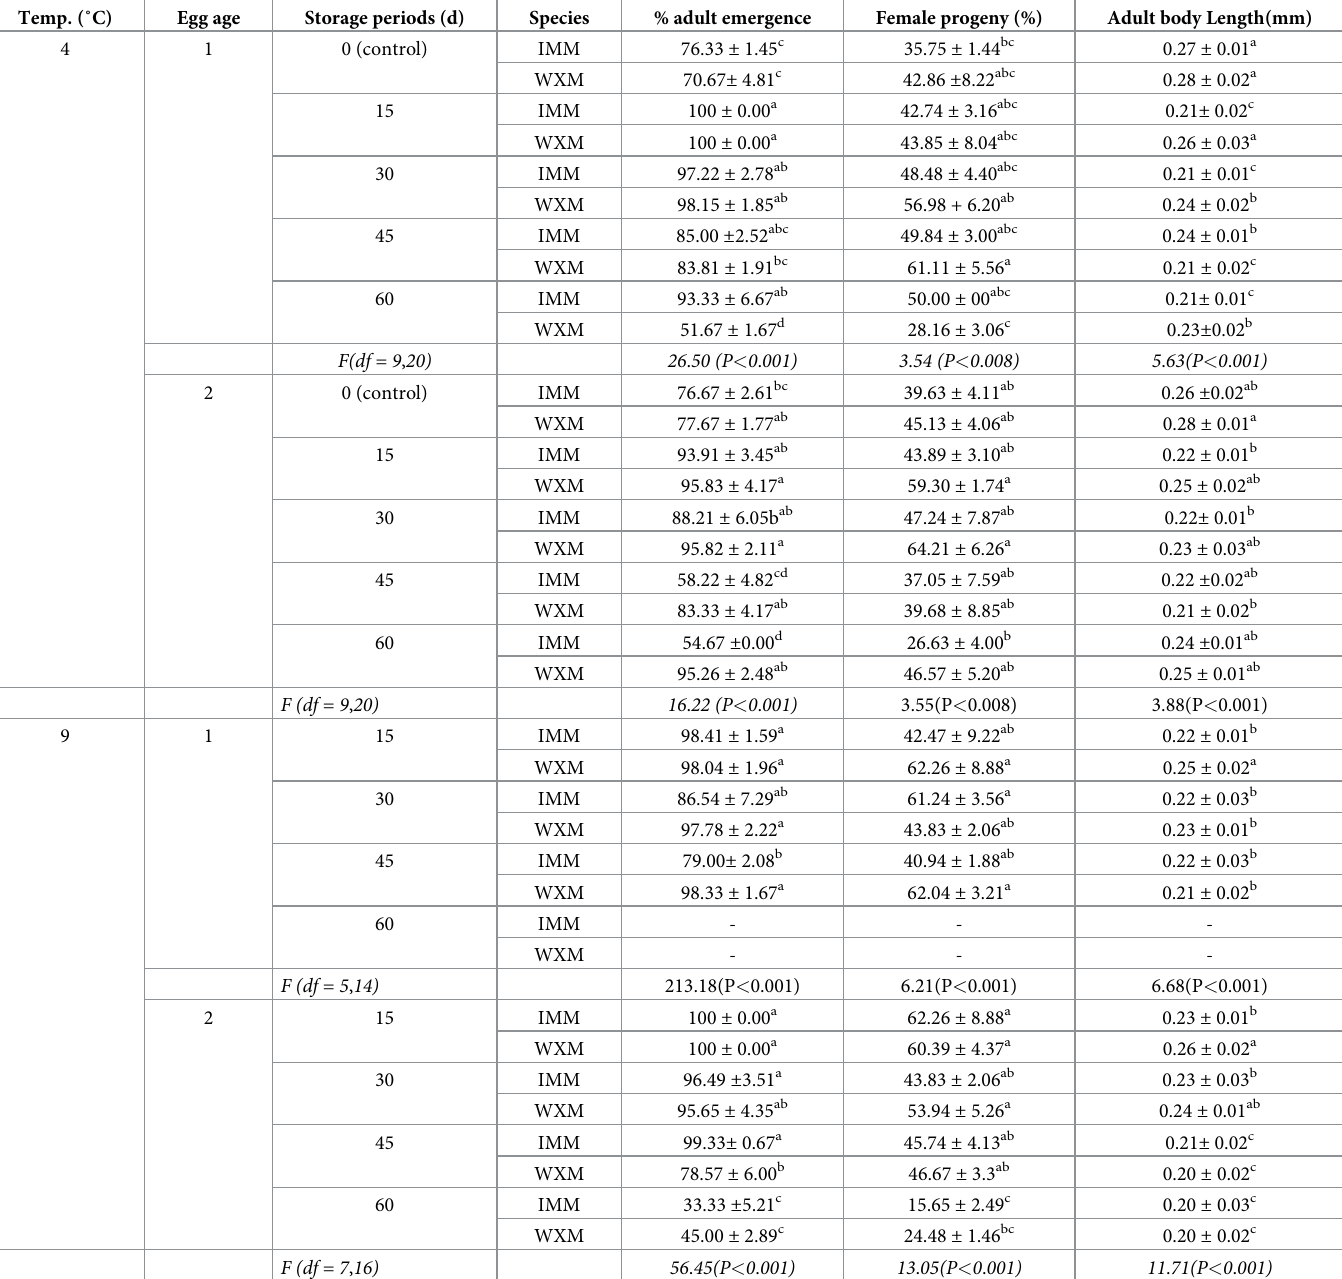
Table 2. Mean ( ± SE) effect of cold storage preservation on the biological traits of T . evanescens reared on eggs of P . interpunctella (IMM) and G . mellonella (WXM), placed either alone or simultaneously that were maintained at either 4or 9˚C, at different intervals. Temp.